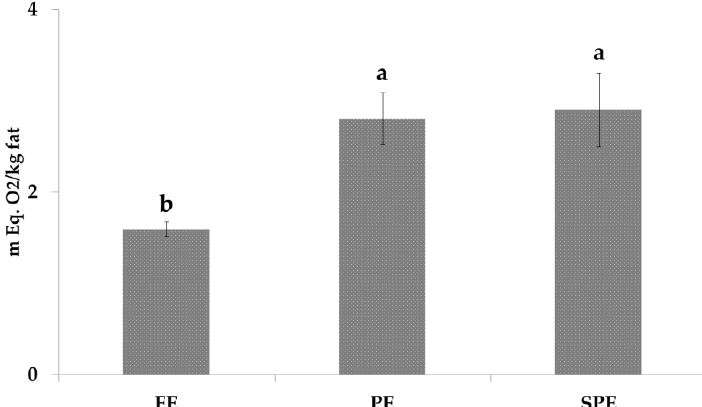
Figure 1. PV amounts (mEq. O2/kg fat) in fresh eggs (FE), pasteurized (PE) and spray-dried (SPE) egg products. Different letter means statistical difference ( p < 0.05) . PV: peroxide values.